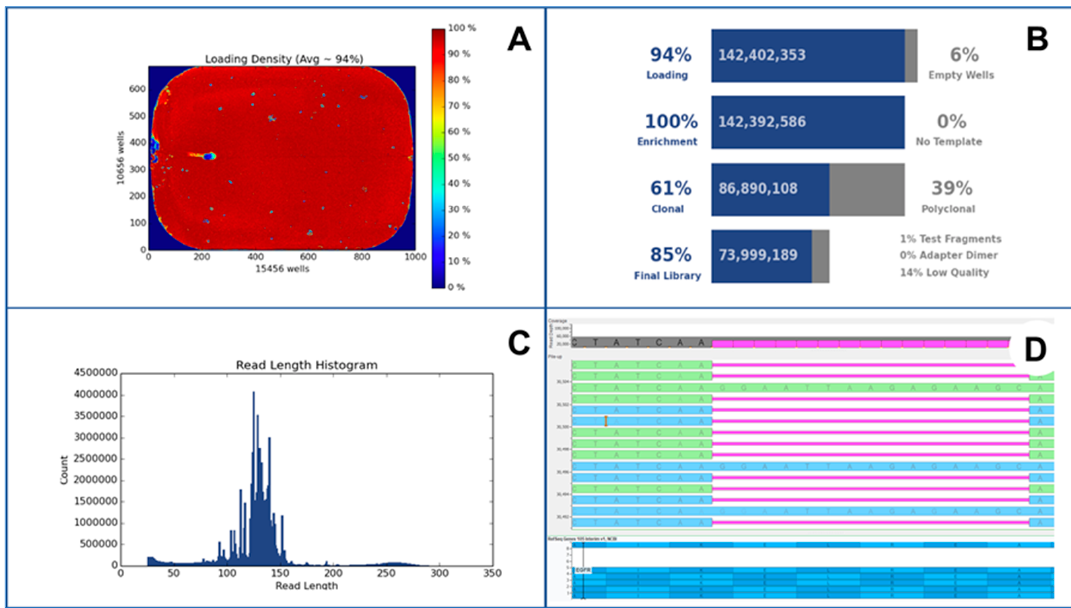
Figure 3. An exemplificative case of EGFR exon 19 deletion p.A746_A750 del detected by using NGS Ion Torrent S5 (Thermo Fisher Scientifics) platform. In this figure, loading density ( A ), technical quality parameters ( B ), read length histogram ( C ) and visual inspection of detected mutations with Golden Helix Genome Browse tool ( D ) were observed.